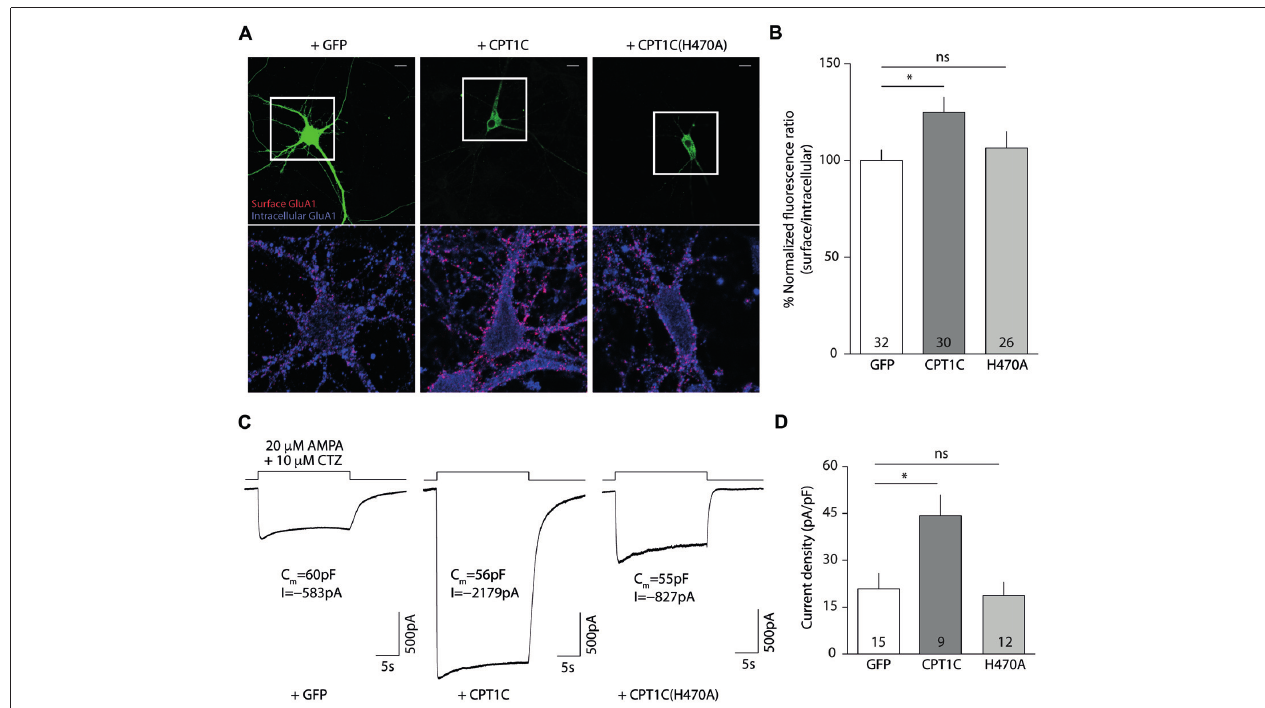
FIGURE 6 | CPT1C but not CPT1C(H470A) increases functional AMPAR surface expression in CPT1C KO pyramidal neurons. (A) Representative confocal IF images of 11 DIV hippocampal pyramidal neurons in culture from CPT1C KO mice transfected with GFP (left images), CPT1C (middle images) or CPT1C(H470A), (right images). Upper panels display the analyzed transfected neuron. Surface GluA1 (Alexafluor 555; red signal) and intracellular GluA1 (Alexafluor 647; blue signal) is shown in the lower panels for the three different conditions. Scale bars: 10 µ m. (B) Quantification of endogenous somatic GluA1 surface to intracellular ratio from CPT1C KO pyramidal cells in culture. GluA1 ratio was increased in neurons transfected with CPT1C compared with GFP ( ∗ p = 0.0132; Mann-Whitney U-test) while CPT1C(H470A) was not able to significantly increase GluA1 ratio ( ns p = 0.8551; Mann-Whitney U-test). Numbers in bars indicate the number of neurons analyzed. (C) Endogenous AMPAR somatic currents evoked by rapid application of 20 µ M AMPA +10 µ M cyclothiazide during 20 s from CPT1C KO hippocampal pyramidal neurons transfected with GFP (left trace), CPT1C (middle trace) or CPT1C(H470A), (right trace). Three neurons with similar cell capacitance are shown. (D) Quantification of peak responses (shown as current density) from CPT1C KO pyramidal neurons in the conditions mentioned in (C) . Currents were clearly increased in neurons expressing CPT1C but not in cells expressing CPT1C(H470A). Numbers inside bars denote the number of recorded cells.